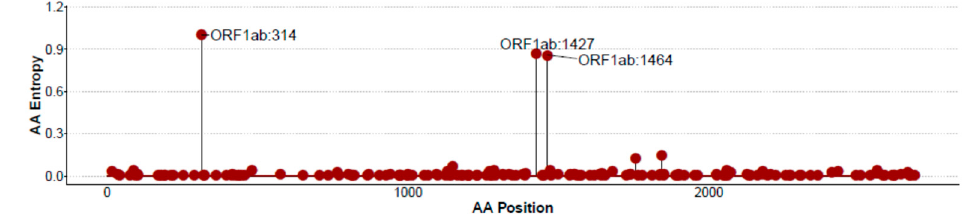
Figure 1. Standard Shannon entropy plot by amino acid position for ORF1ab. Zero entropy indicates total conservation at each specific position.